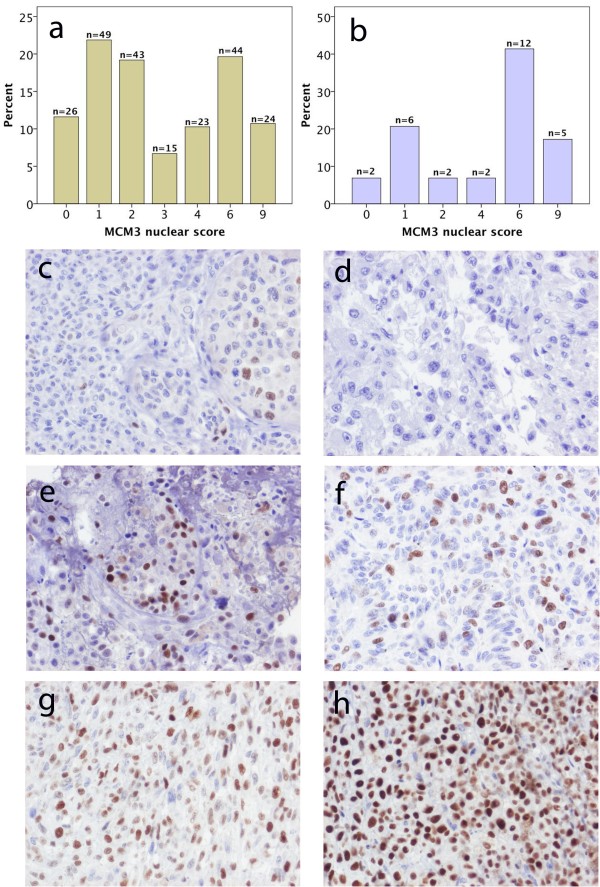
Distribution and sample immunohistochemical images of MCM3 expression in primary and metastatic melanoma. Distribution of immunohistochemical MCM3 expression denoted as the multiplier of fraction and intensity of staining (nuclear score = NS) in a) primary melanoma and b) metastases. Sample images of MCM3 expression in primary tumour and paired metachronous metastasis: c) nodular melanoma on left ear (NS = 2) and d) lymph node metastasis in left groin (NS = 0); e) superficial spreading melanoma on lower left leg (NS = 6) and g) cutaneous metastasis on back of neck (NS = 4); nodular melanoma on lower right leg (NS = 6) and cutaneous metastasis on lower right leg (NS = 9).